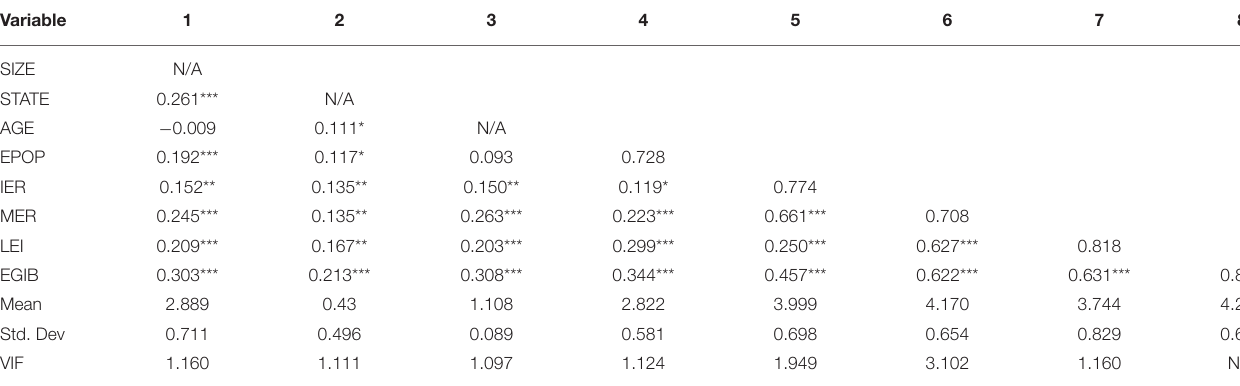
TABLE 2 | Descriptive statistics and correlation analysis ( N =